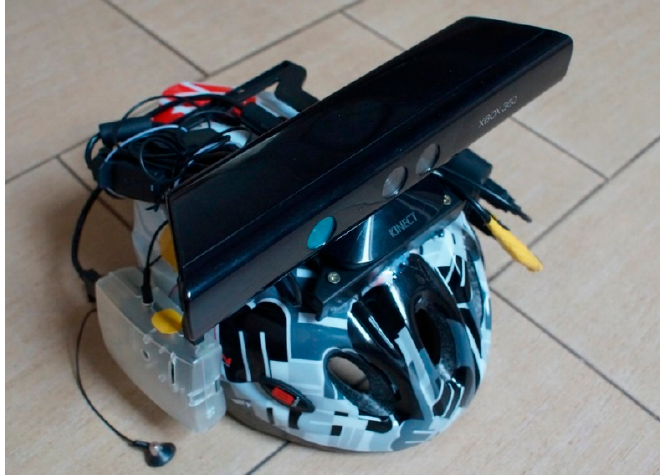
Figure 6. A prototype of our device containing a Raspberry Pi computer with memory card and housing, Xbox Kinect sensor, power bank, sensor holder, headphones and bicycle helmet.